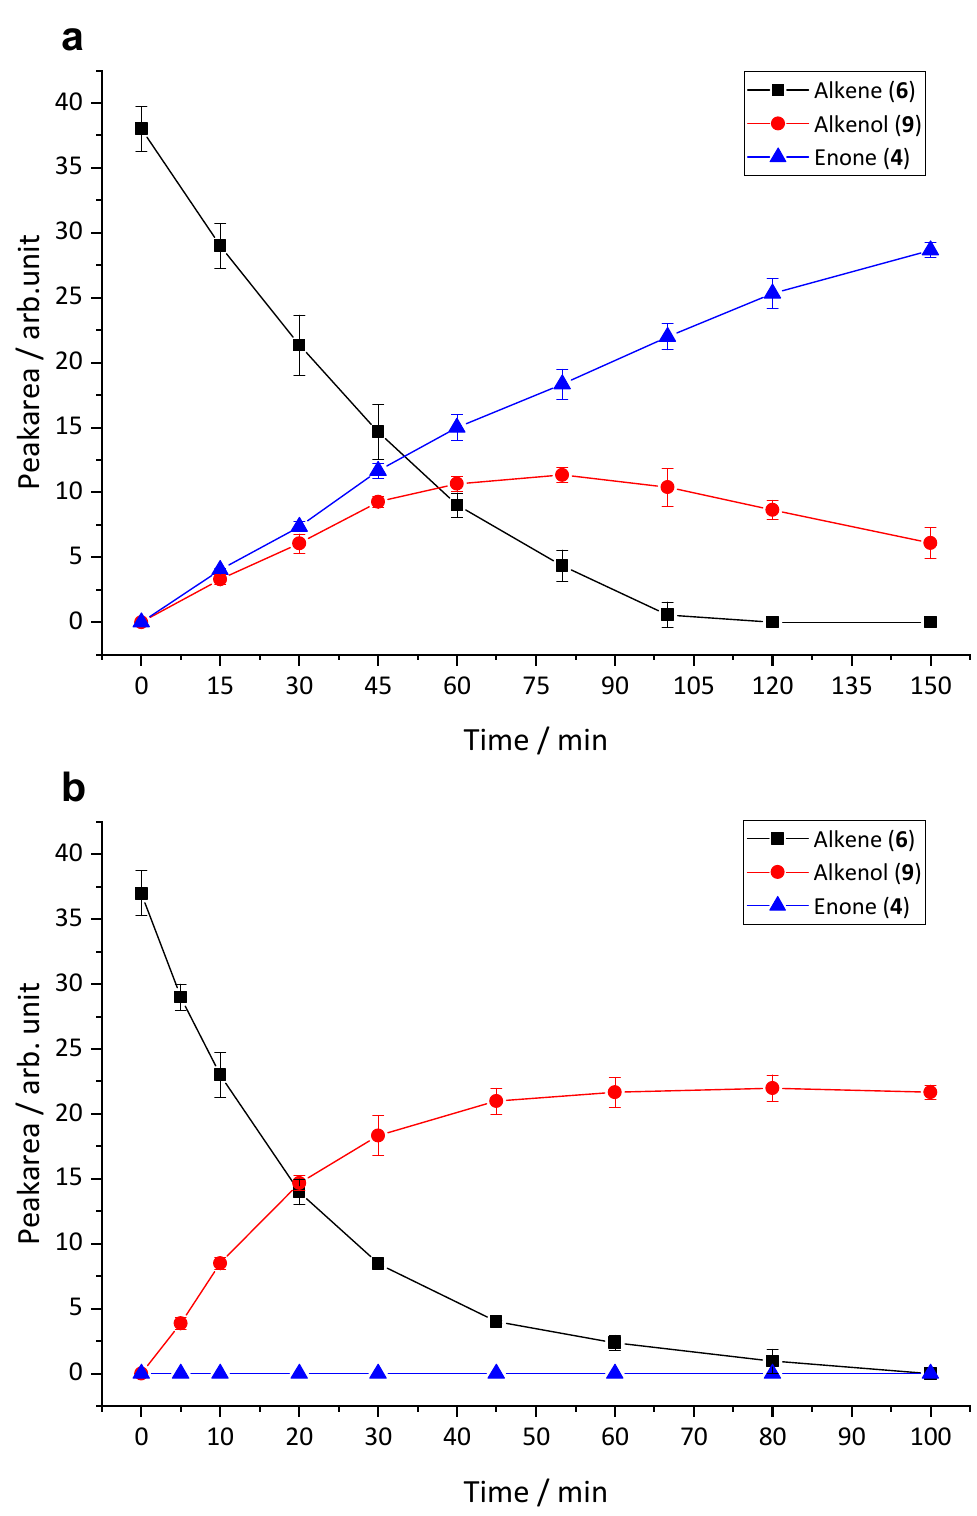
Figure 8. Time course of metabolism of 6 in microsomes from humans ( a ) and rats ( b ). In both species, metabolism of 6 (black curve) generates an intermediate alkenol 9 (red curve). In human but not in rat liver microsomes, 9 is further metabolized to 4 (blue curve). Data points represent the mean ± SD of three independent experiments.